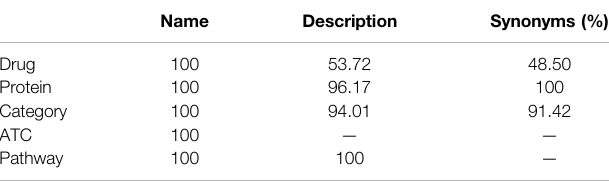
TABLE 3 | The percentage of nodes that have each type of